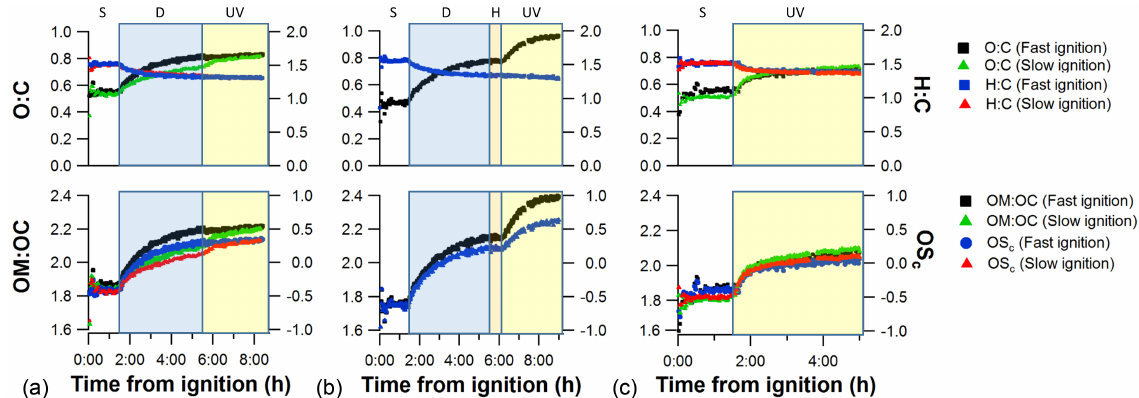
Figure 3. Effect of aging on OA elemental composition for experiments (a) 1B and 2B, (b) 3B and (c) 4B and 5B. Stabilization is marked as S, dark aging as D, HONO addition as H and UV aging as UV.